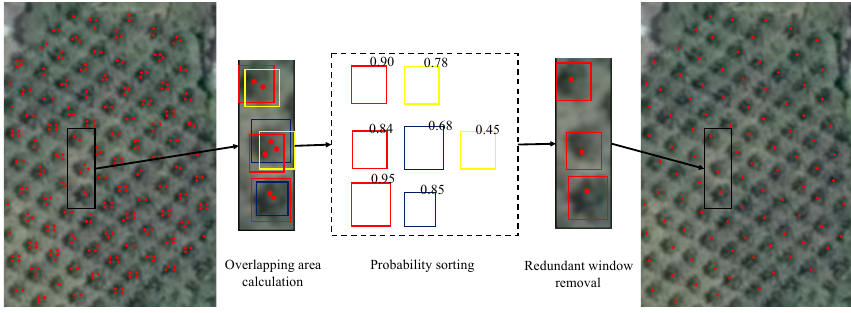
Figure 9. The process of non-maximum suppression